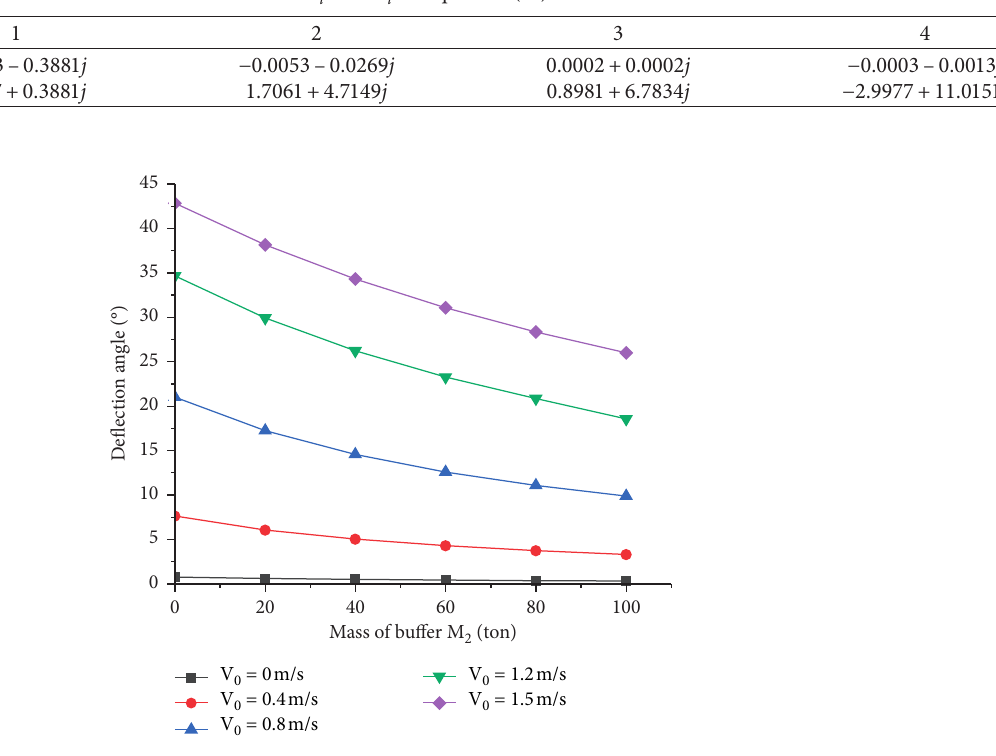
Table 6: Values of A